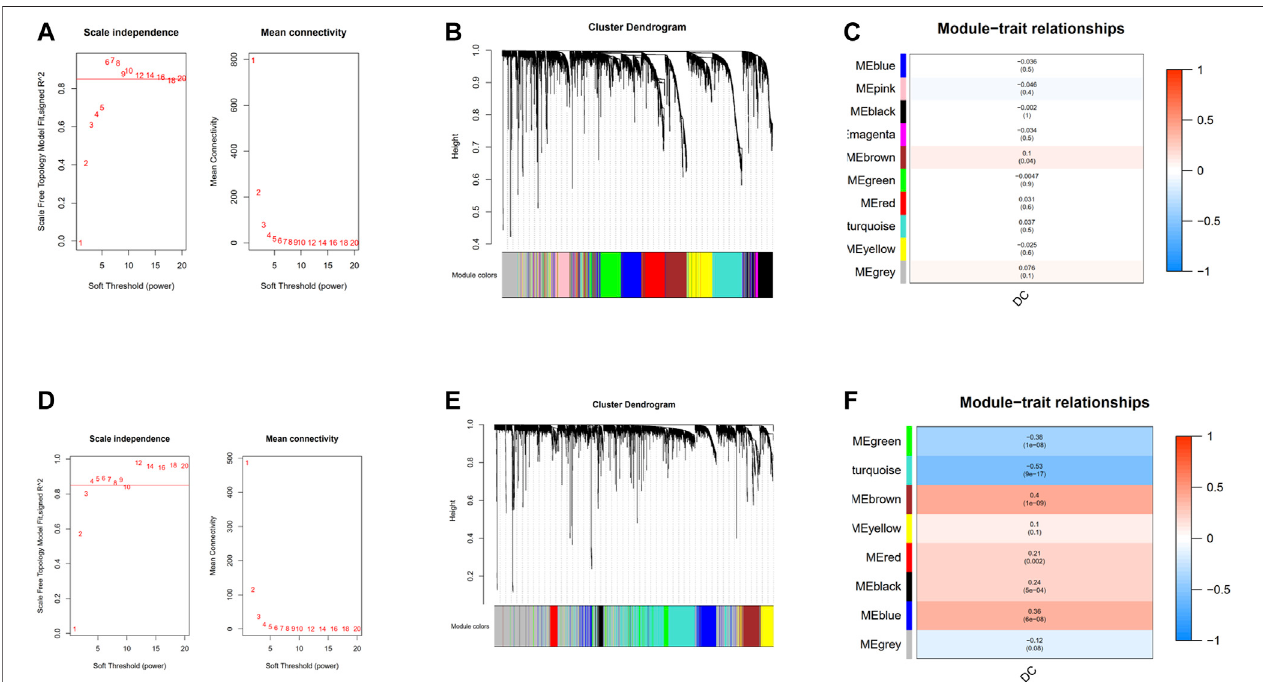
FIGURE3| Constructionofweightedgeneco-expressionnetwork. (A) Analysisofthescale-freenetworkcoef fi cientR-squaredforthesoftthresholdandthemean connectivityforthesoftthresholdintheTCGAcohort. (B) Aclusterdendrogramof10networkmodulesintheTCGAcohort. (C) Heatmapofcorrelationbetweenmodule eigengenes and DCs in the TCGA cohort. (D) Analysis of the scale-free network coef fi cient R-squared for the soft threshold and the mean connectivity for the soft threshold in the GEO cohort. (E) A cluster dendrogram of eight network modules in the GEO cohort. (F) Heat map of correlation between module eigengenes and DCs in the GEO